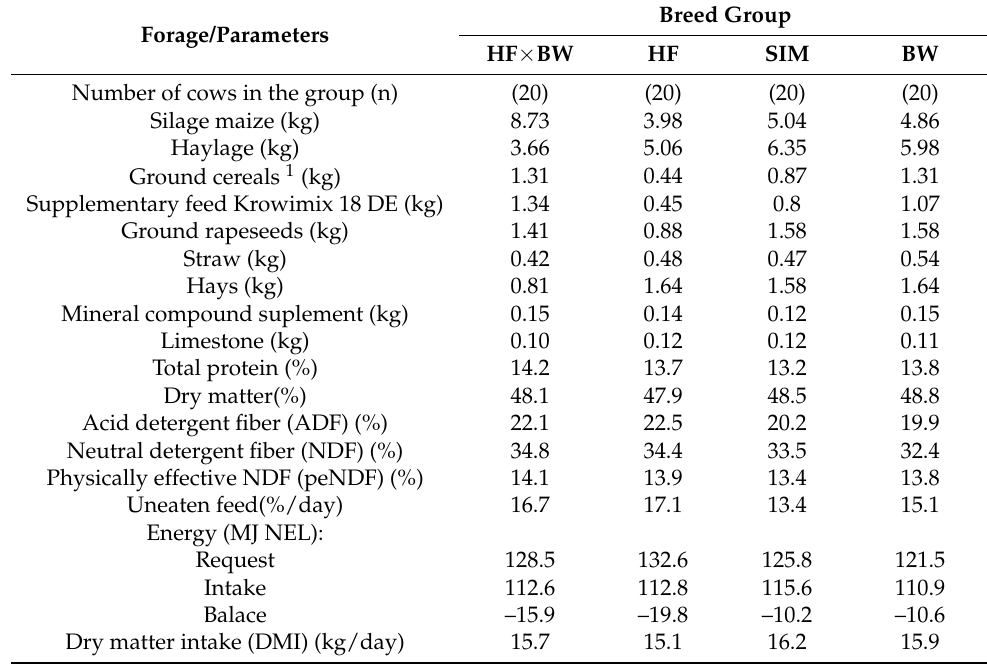
Table 1. Feed components and balancing of the diet of the genetic groups. Sample collection and analytical methods. HF—Holstein-Friesian, BW—Black-and-White Lowland, SIM—Simmental.